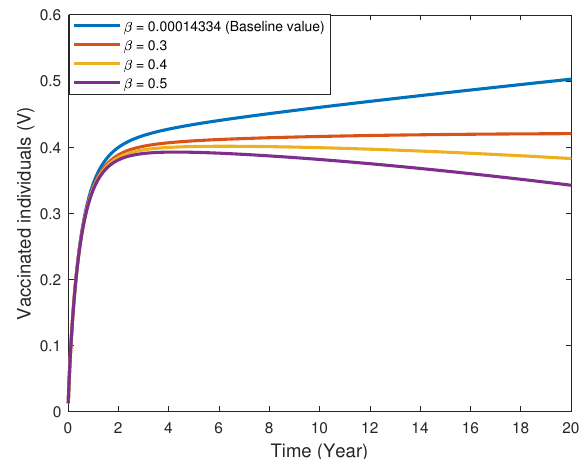
Figure 14. Behavior of V class for different β